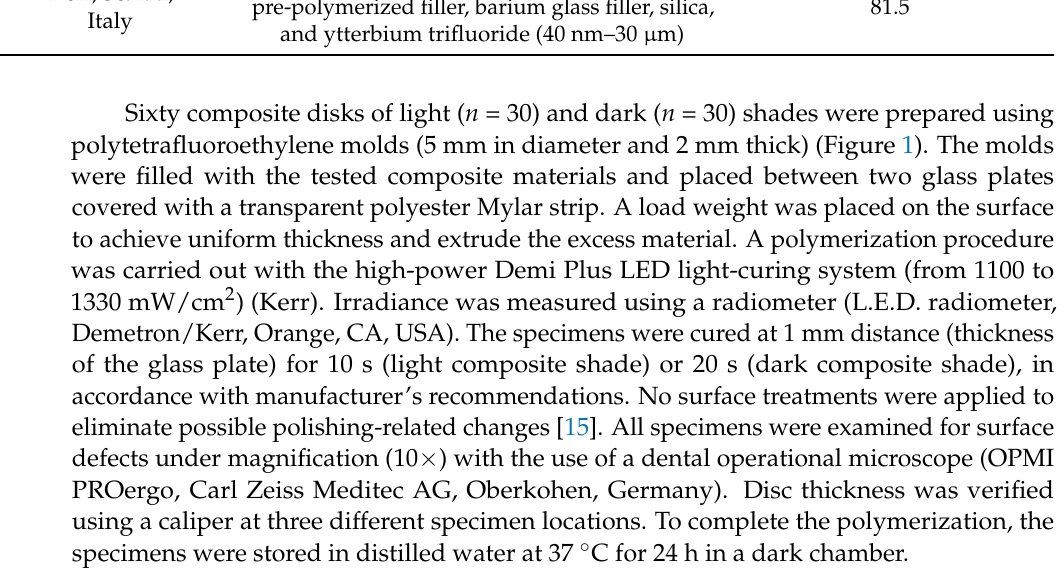
Table 1. Composition of the resin composite material used in this study.